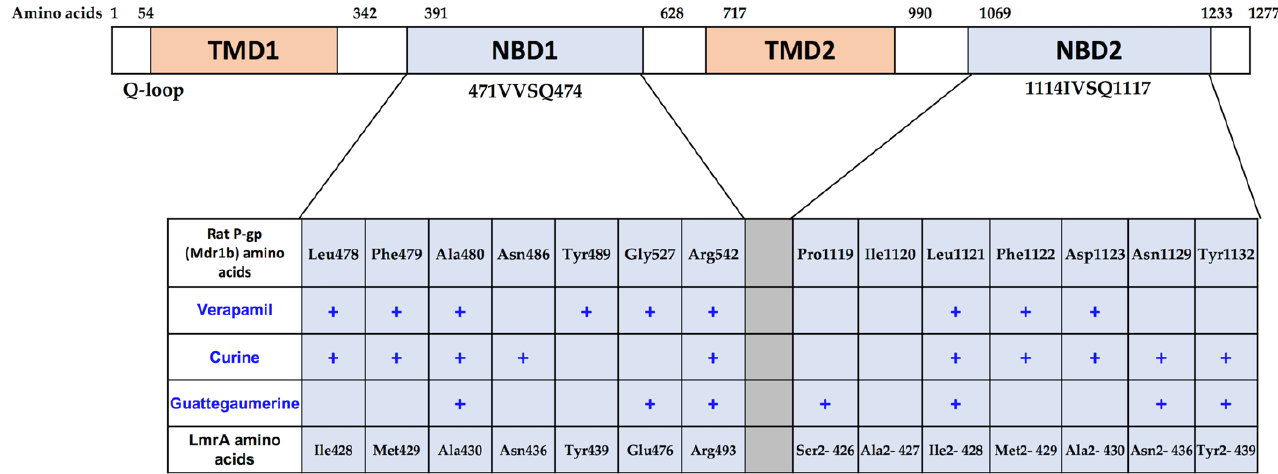
Figure 8. Diagram of rat Mdr1b and LmrA amino acids of the NDB domains involved in binding with drugs. The top of the figure shows a simple diagram of the protein with 1277 amino acids with the positions occupied by the two transmembrane domains (TMDs) and the two nucleotide-binding domains (NBD). The amino acids involved in drug binding deduced from the docking analysis of rat P-gp (Mdrlb) and LmrA are shown in the table. Amino acid sequences of rat Mdr1b and of Lactococcus lactis LmrA were obtained from the Swiss Prot database (access code: P43245) and UniProtKB/Swiss-Prot database (access code: P97046),